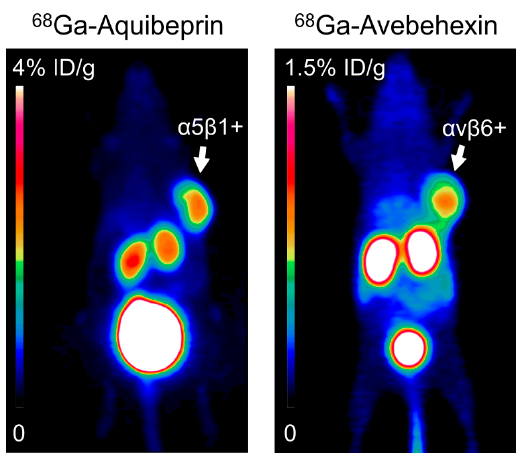
Figure 4. Imaging of various integrin subtypes.